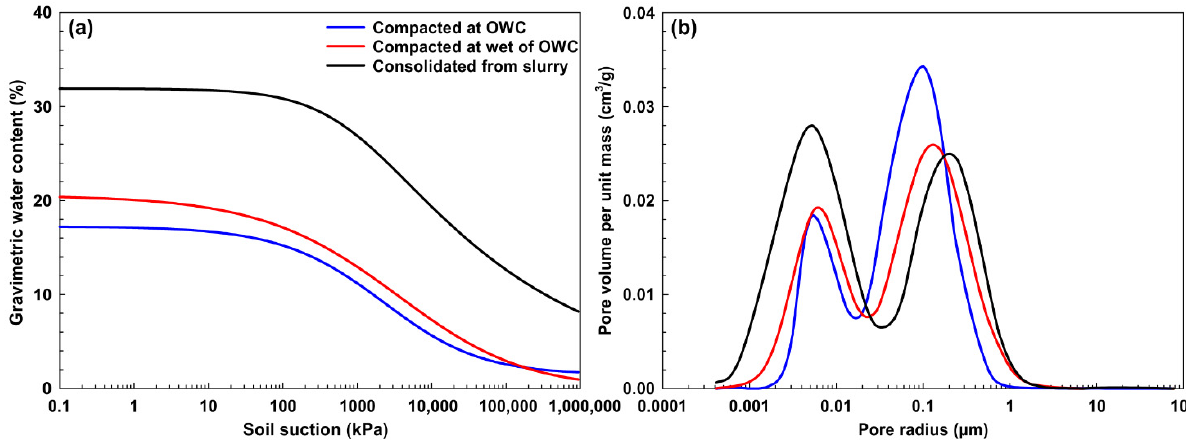
Figure 18. Relationship with ( a ) SWCC and ( b ) PSD of No.